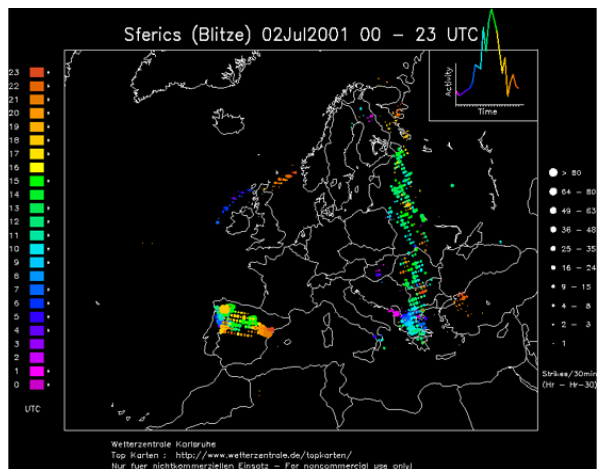
Fig. 17. Date: 23 June 2005, CL5. Spatial, temporal and intensity distribution of lightning